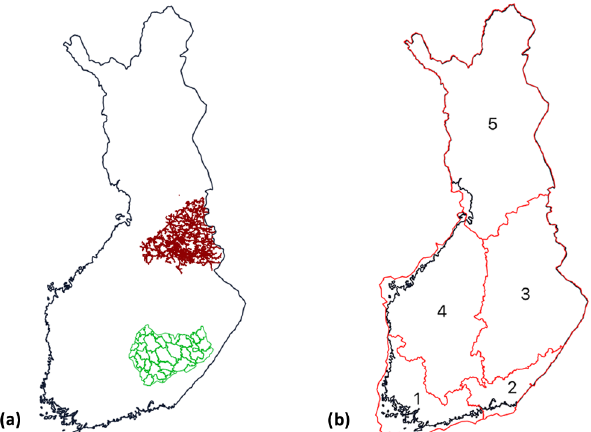
Figure 1. (a) Geographical coverage of the outage data (local dataset). The red lines represent the power grid of Loiste (north- ern grid company) and the green lines the operative areas of JSE (southern grid company). Outages of the local dataset are collected from both areas. (b) Regions in the national outage dataset. Out- ages are gathered from all of Finland and aggregated to the regions shown in the